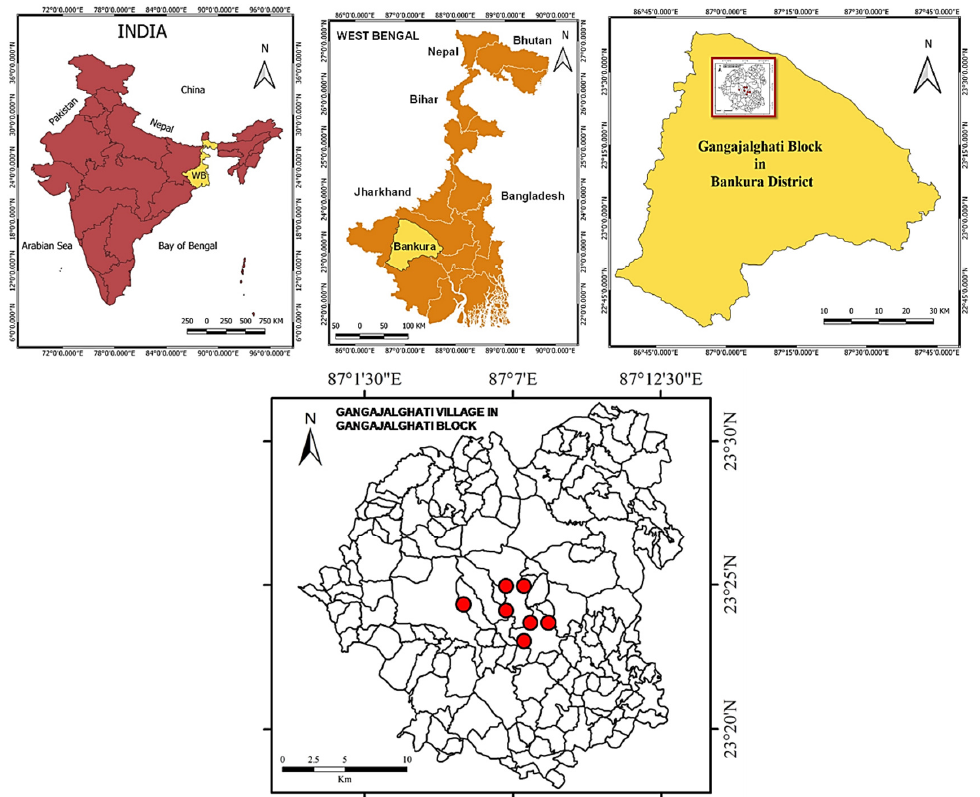
Figure 1. Geographical location of the study area: Seven study sites in Gangajalghati block of Bankura district, West Bengal, India (Map data: India and West Bengal from Nayak, 2020 with permission from the publisher; Bankura district was generated using QGIS; Gangajalghati Block modified after Das,